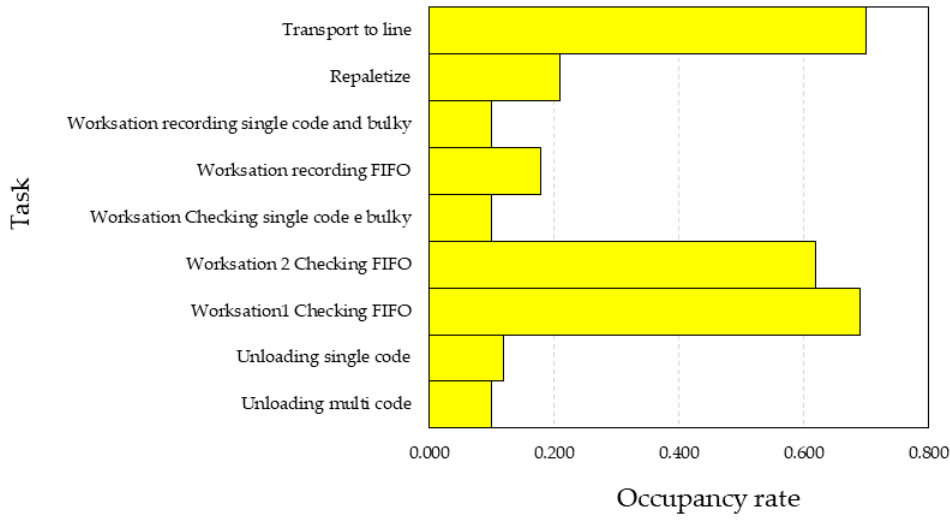
Figure 10. Occupancy rate by workstation. Table 6. Occupancy rate per task—Waiting Time.